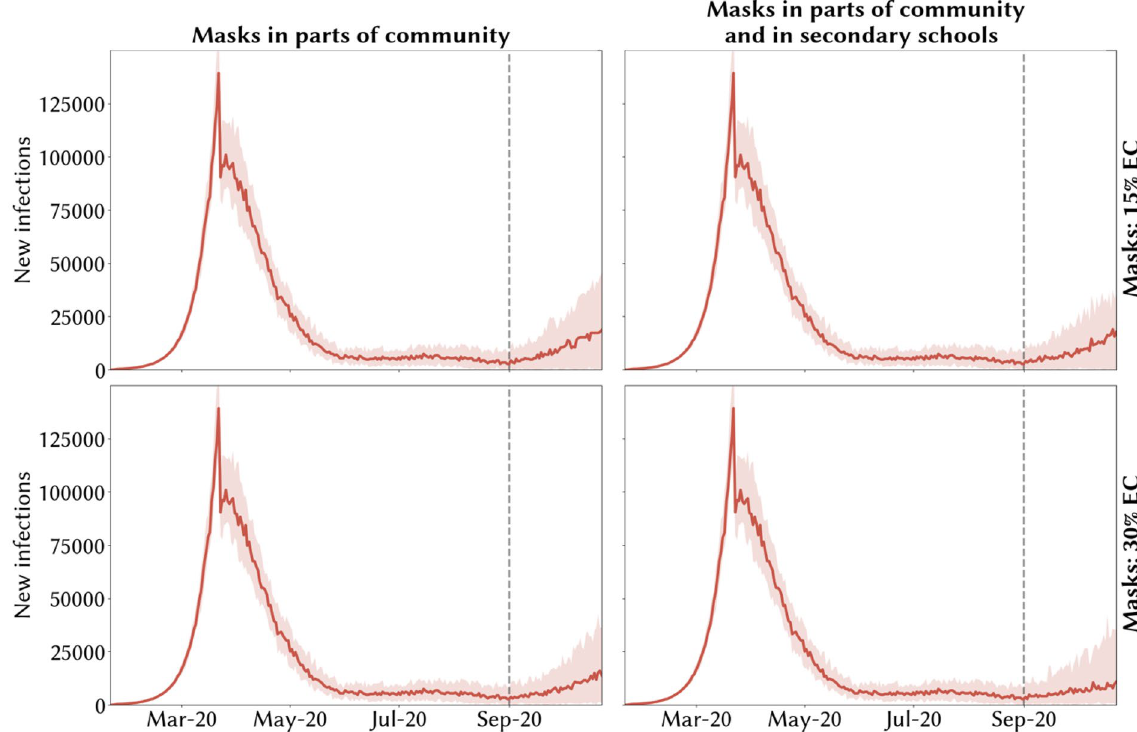
Figure 4. Model scenarios of potential second COVID-19 epidemic wave in the UK during 2020 under different policies of mask wearing and effective coverage for testing and tracing levels where future the resurgence of COVID-19 is prevented. Medians across 30 simulations are indicated by solid red lines and 10% and 90% quantiles by red shading. The resurgence of COVID-19 after September 2020 is controlled and